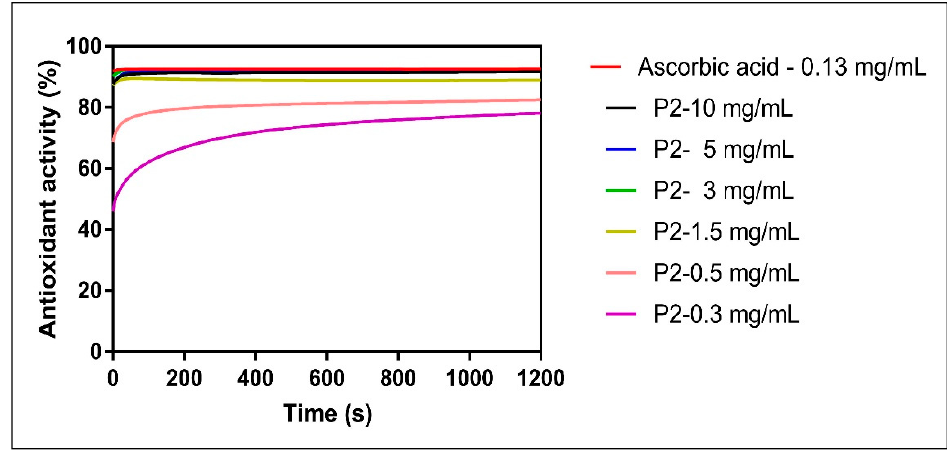
Figure 6. The time-dependency of radical scavenging activity for P2 sample vs. ascorbic acid.